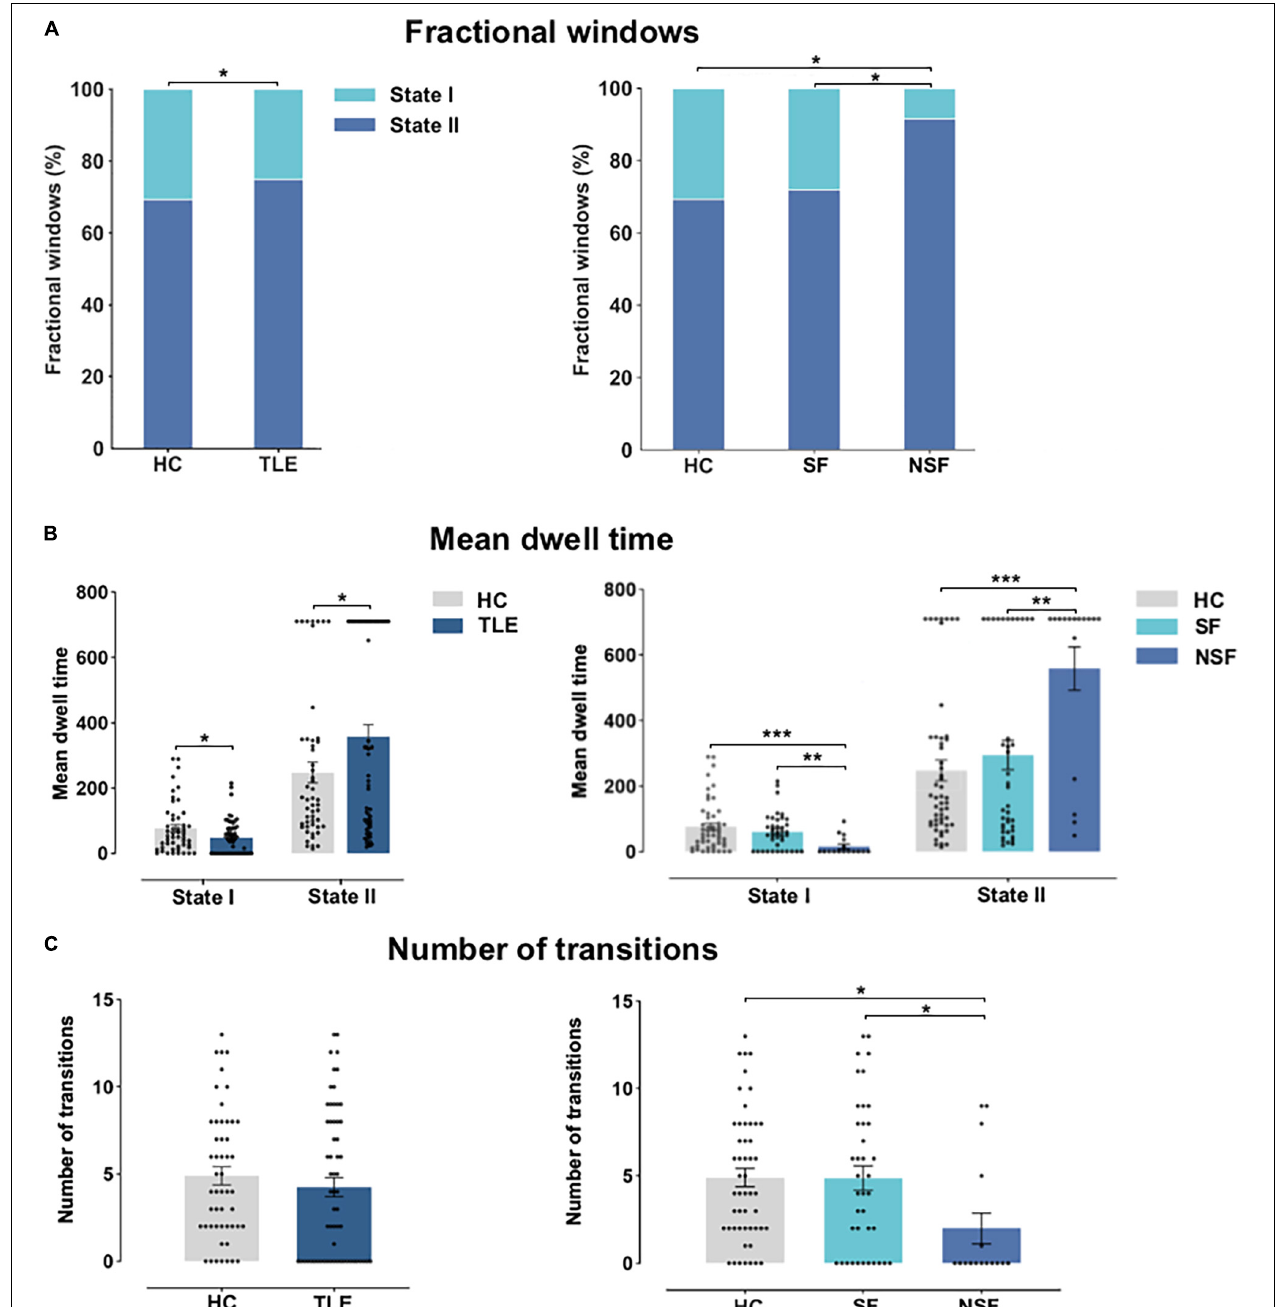
FIGURE 4 | Temporal properties of DFNC for TLE and HC, and across TLE surgical outcome subgroups. (A) Fractional windows: Percentage of total time subjects spent in each state. (B) Mean dwell time and (C) number of transitions between states. Asterisks indicate statistically significant group differences based on significant post hoc t-tests ( P < 0.05, FDR-corrected). HC, healthy controls; NSF, not seizure-free; SF, seizure-free; TLE, temporal lobe epilepsy. * P < 0.05; ** P < 0.01; *** P <